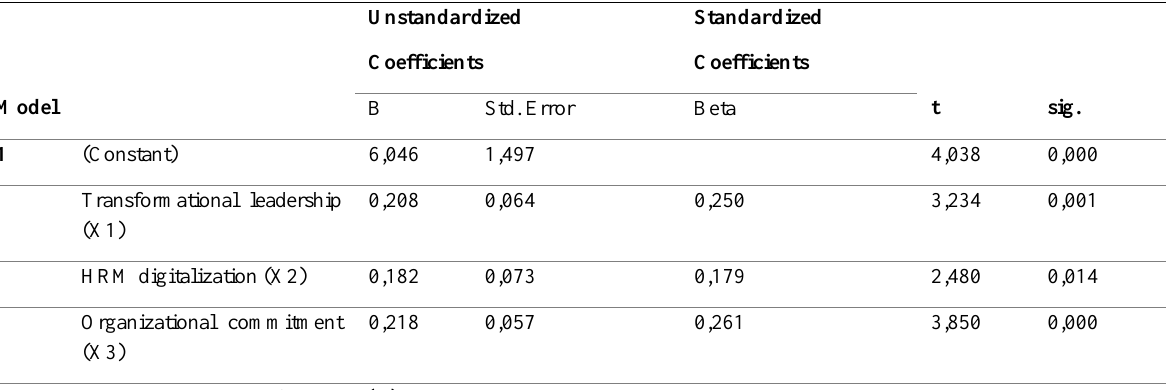
Table 4: Regression